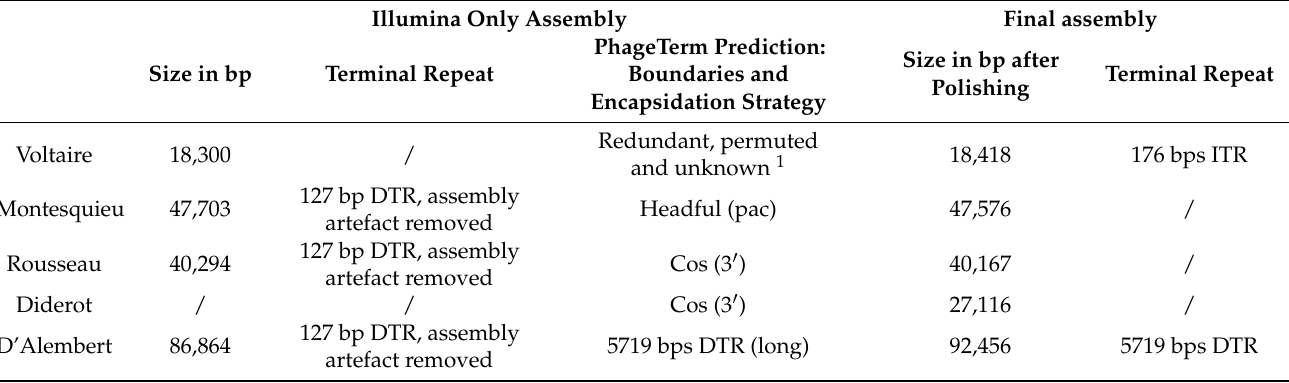
Table 6. Completeness and encapsidation strategy for the five